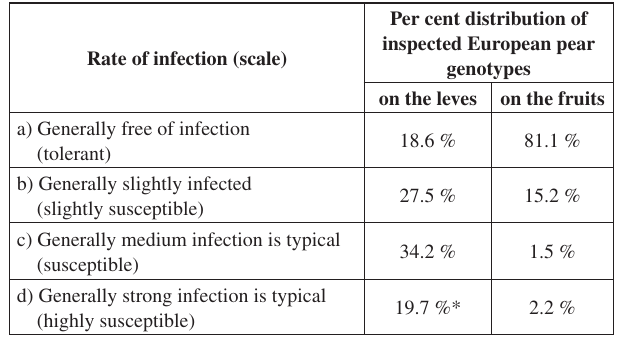
Table 3. Distribution of European pear genotypes (commercial cultivars, conventional land varieties, registered local clones, seedlings, wild seedlings) according to their fi eld sensitivity to Venturia pirina infection (’Újfehértó’ pear gene bank, Hungary)